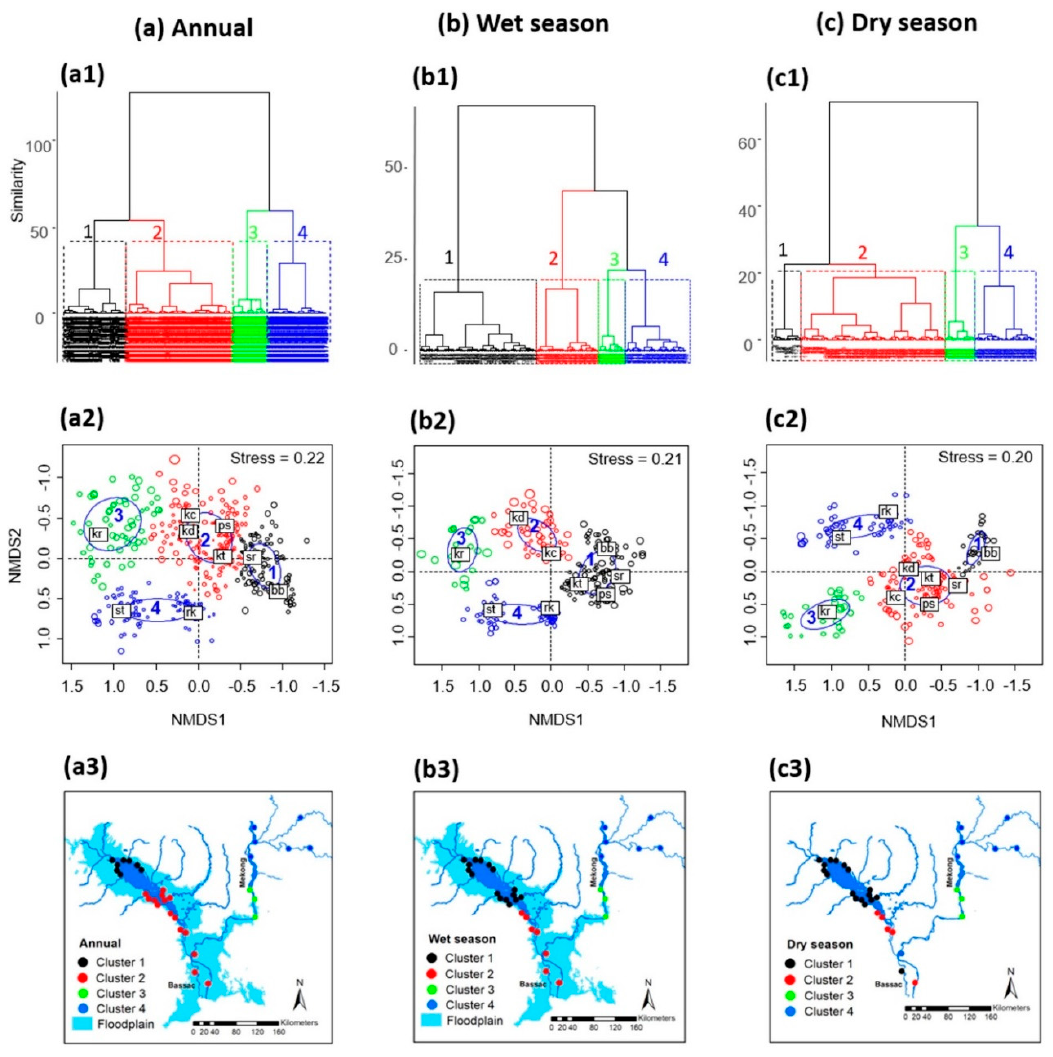
Figure 2. Freshwater fish distribution patterns in Cambodia: ( a ) Annual, ( b ) wet season and ( c ) dry season. ( a1 , b1 , c1 ) are the Ward hierarchical clustering dendrograms of the weekly relative abundance showing four distinct clusters for the annual, wet season and dry season, respectively. ( a2 , b2 , c2 ) are NMDS biplots of the relative weekly fish abundance samples (with Bray–Curtis dissimilarity matrix) showing distribution patterns of freshwater fish assemblages in Cambodia for the annual, wet season and dry season, respectively. ( a3 , b3 , c3 ) are fish assemblage clusters visualized on the map for the annual, wet season and dry season, respectively. The letters on the MNDS biplots indicate the abbreviations of the study province name. For the province names, see Figure 1.